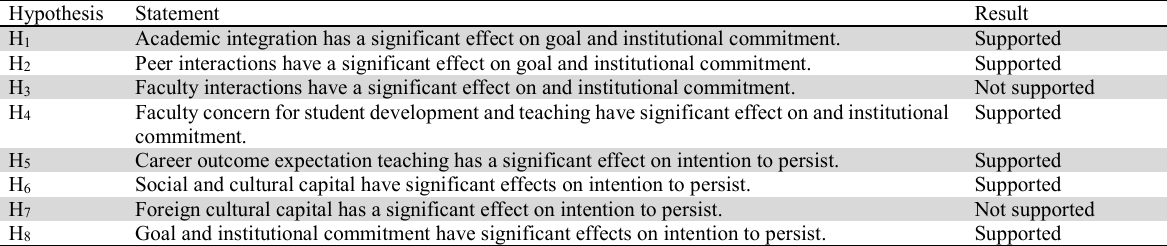
Results of Hypothesis